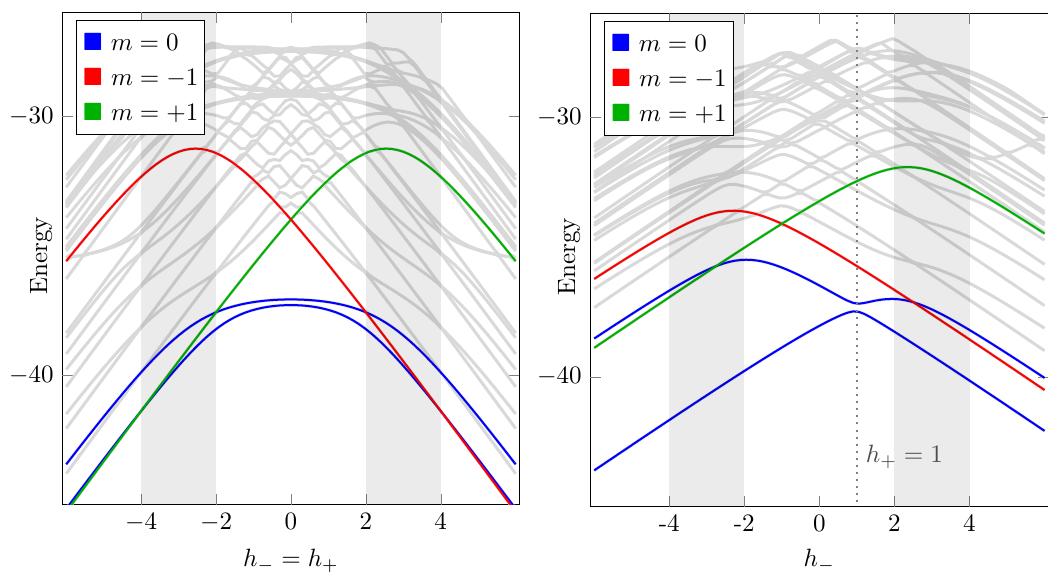
Figure 3: Low energy spectrum for the open boundary XXZ chain ( L = 12 and ∆ = 3) with respect to the boundary fields h − , h + from numerical exact diagonalization. Left : Applying equal boundary fields, h + = h − . The shaded regions correspond to the values between the critical fields ± h ( 1 ) , ± h ( 2 ) and the gray states are other states cr cr with various values of total magnetization. The spectrum is gapped and there are two quasi-degenerate ground states (with difference of energy being exponentially < h < h ( 1 ) small with the system size) in the region − h ( 1 ) , while in all other regions cr cr the spectrum is gapless and there is no exponential degeneracy of the ground state. Right : Spectrum after fixing the boundary field at the right to h + = 1. The lowest energy states are shown in color with their corresponding